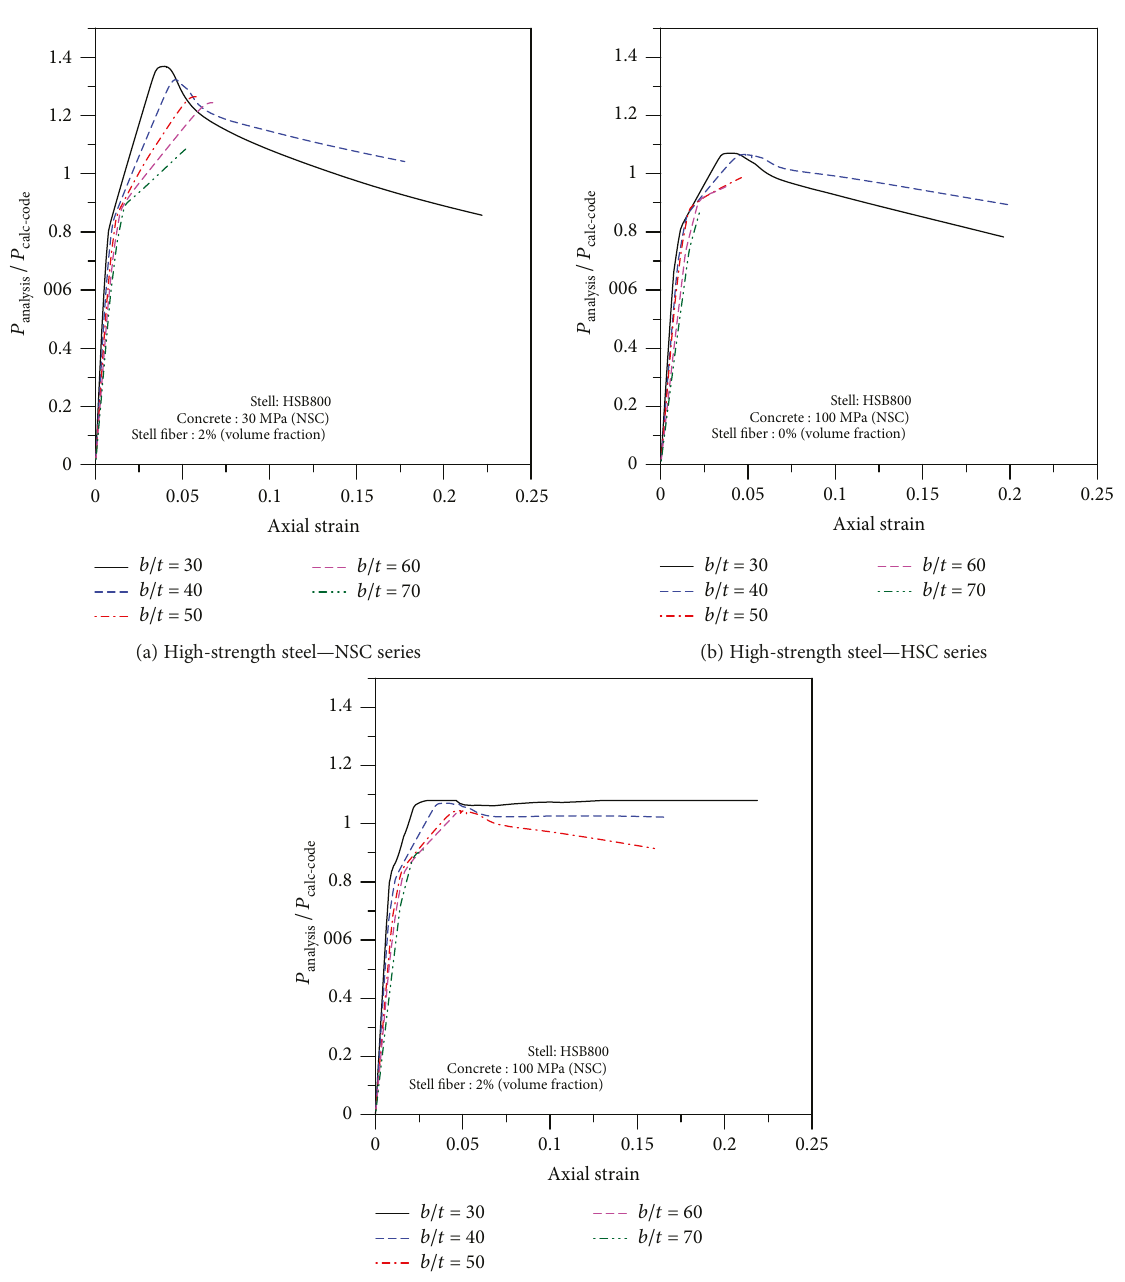
Figure 12: Limit b / t ratio according to matrix strength and steel fi ber